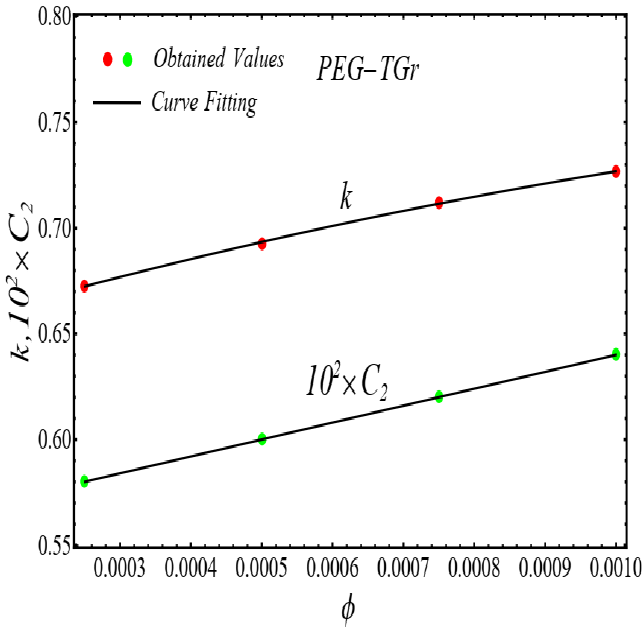
Figure 15. Fitting of the Equation (4) for parameters listed in Table 3.